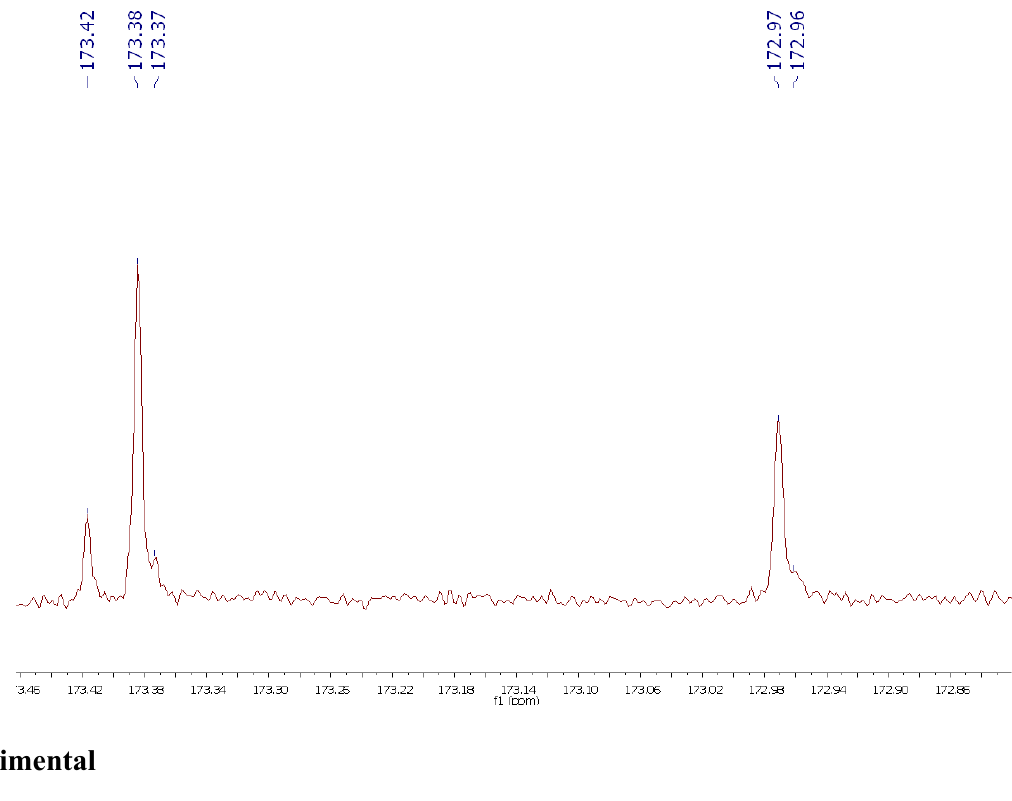
Figure 5. Camellia japonica oil 13 C-NMR spectra (189 MHz) of carbonyl (top) and vynilic (bottom)